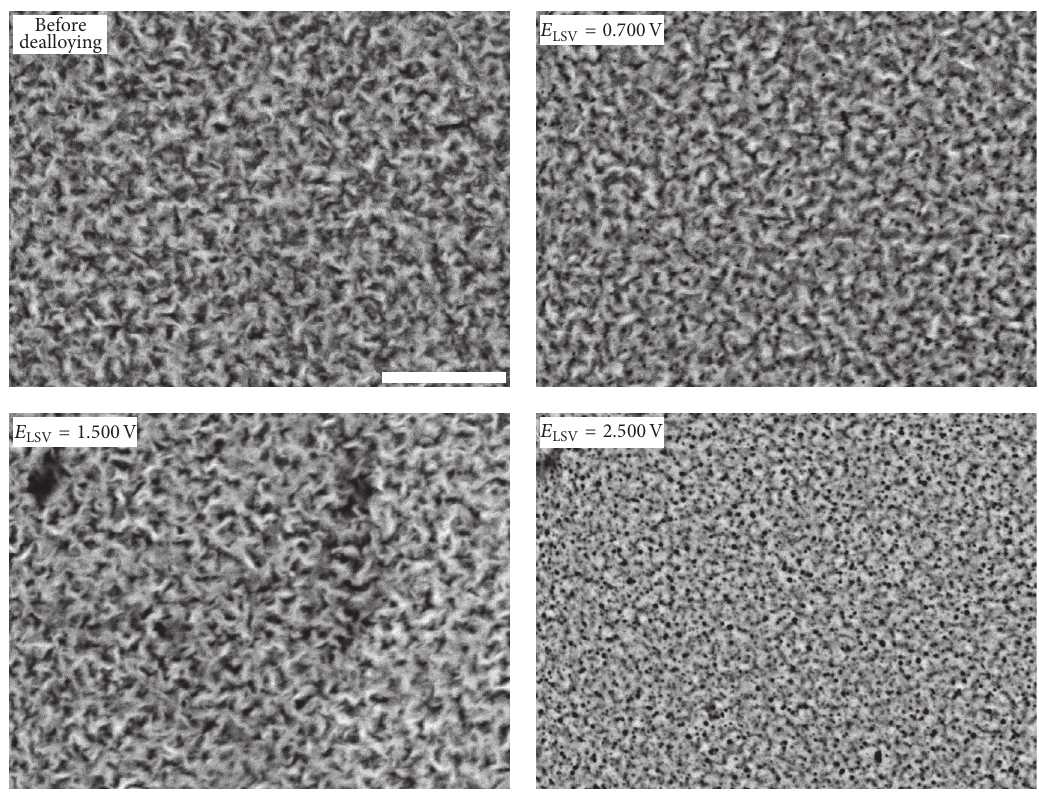
Figure 7: SEM images of samples from the high Ni percentage NiCo samples (Set A) before dealloying and after different dealloying steps. The scale bar is 5 𝜇 m for all the